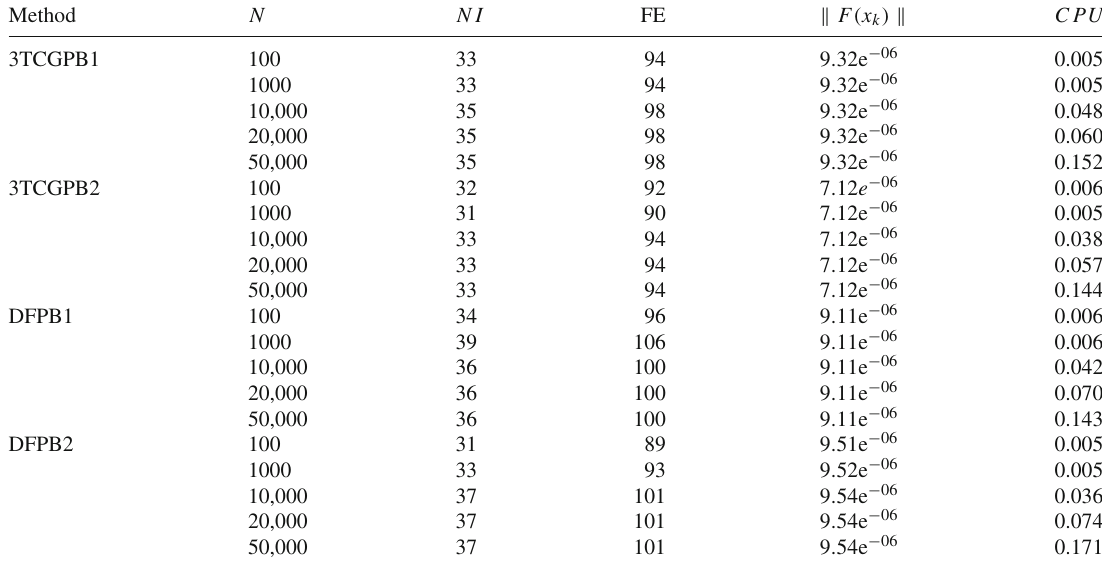
Table 2 Numerical results of Problem